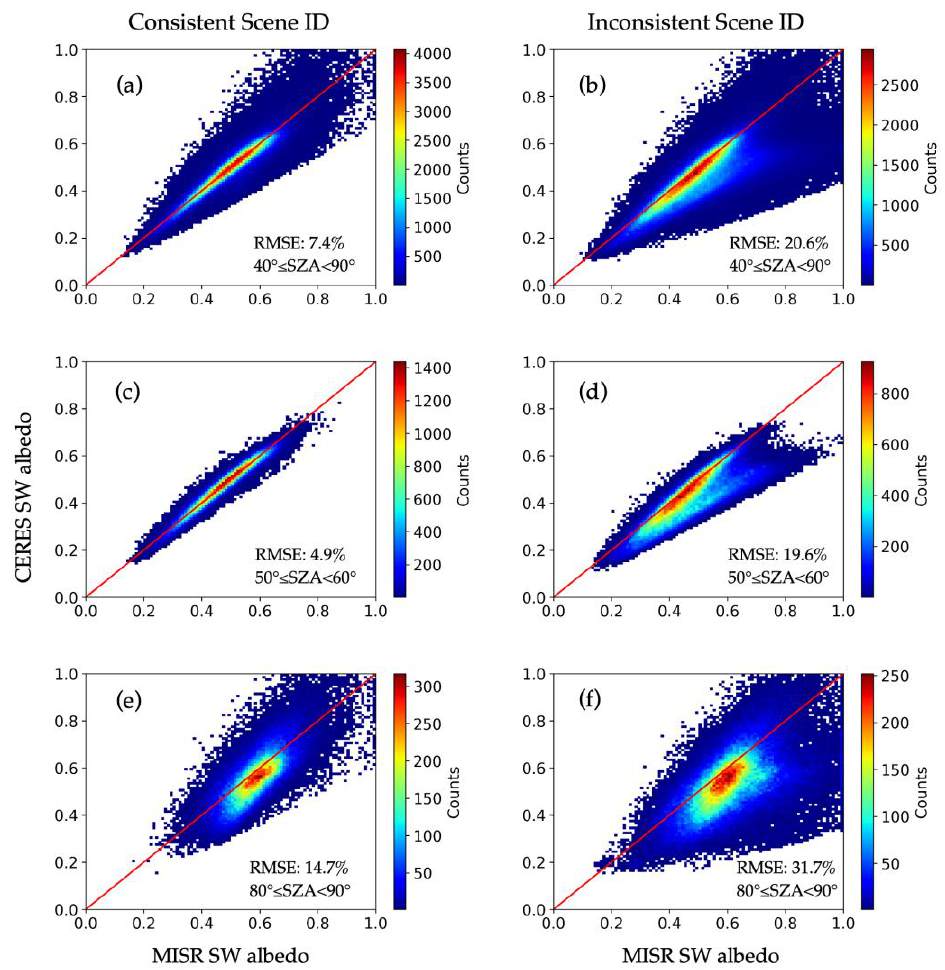
Figure 3. Comparison of CERES and MISR instantaneous overcast albedos over the Arctic ocean for ( a , c , e ) consistent scene type, and ( b , d , f ) inconsistent scene type for solar zenith angle (SZA) ∈ [40°, 90°], [50°, 60°), and [80°, 90°). Table 5. The relative root-mean-square (RMS) difference (%) and relative mean bias (%, in parentheses) between CERES and MISR collocated TOA SW albedos within the Arctic for different solar zenith angle ( θ 0 , unit: degree) ranges and over different surface types (ocean, sea ice (SI), fresh snow (FS), and permanent snow